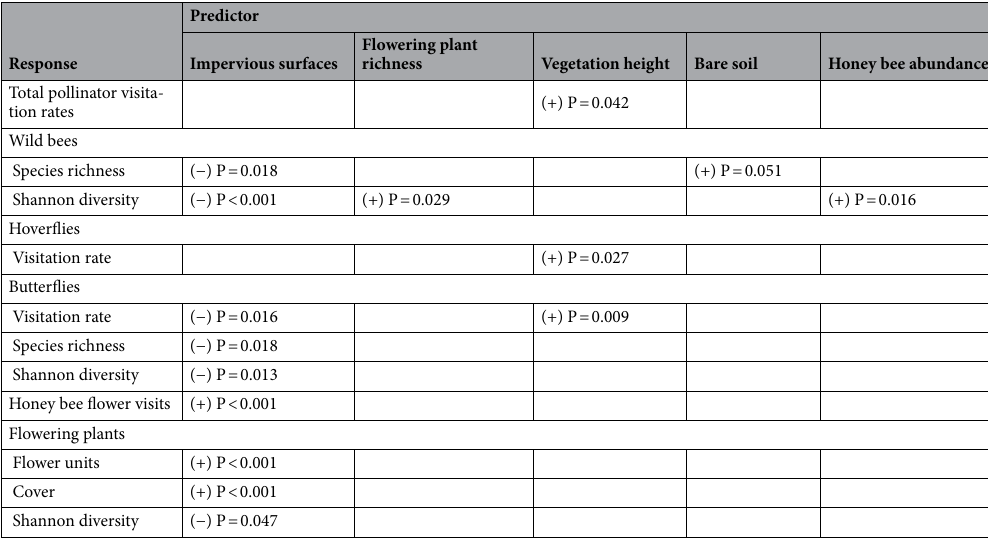
Table 2. The most important predictors of pollinator and flowering plant community